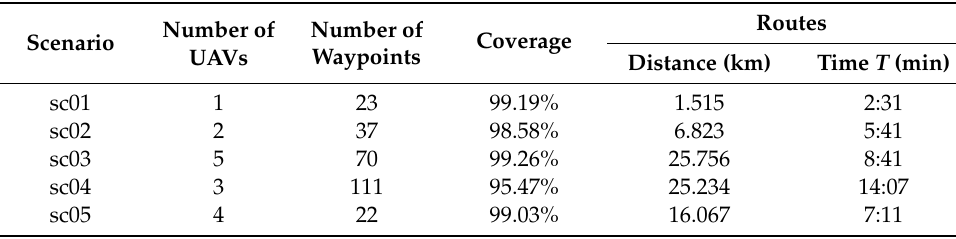
Table 10. Optimizing the routes.